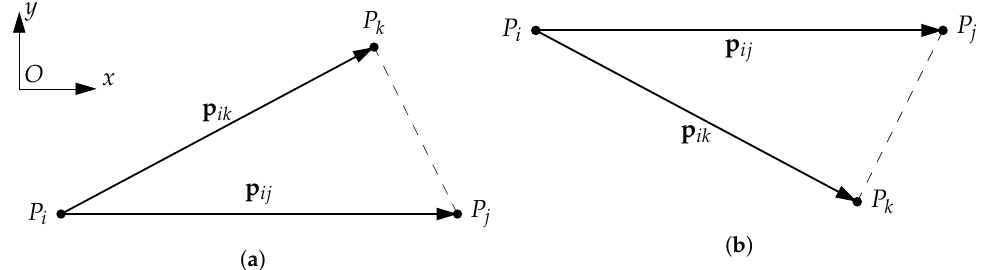
Figure 1. Two possible solutions for bilateration with three points P i , P j and P k on a plane (( a ): solution with points in counterclockwise order, ( b ): solution in clockwise